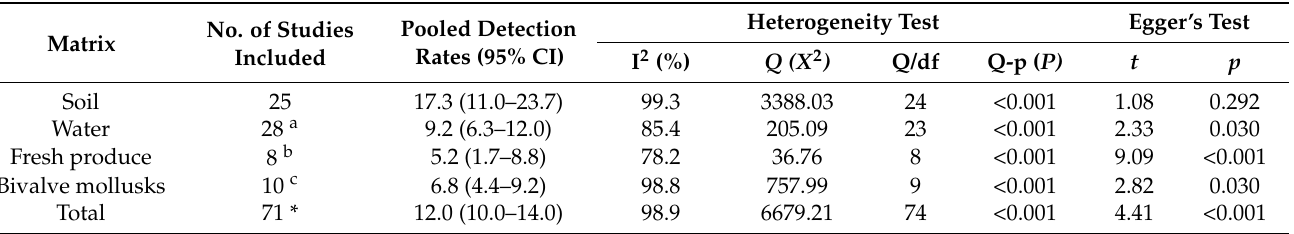
Table 5. Subgroup analysis for comparison of the occurrence of Toxoplasma gondii oocysts detected by molecular methods in each